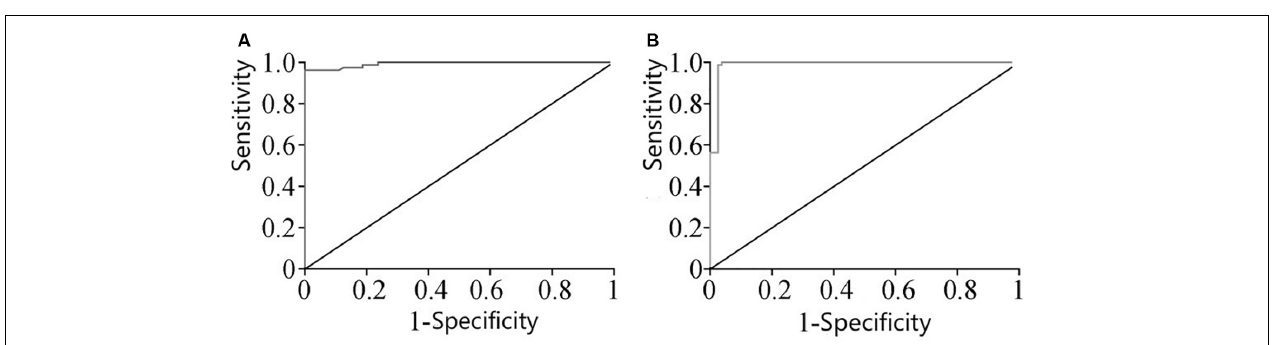
FIGURE 2 | (A) ROC curve of miRNA-126 expression in plasma. (B) ROC curve of miRNA-28-3p expression in plasma.